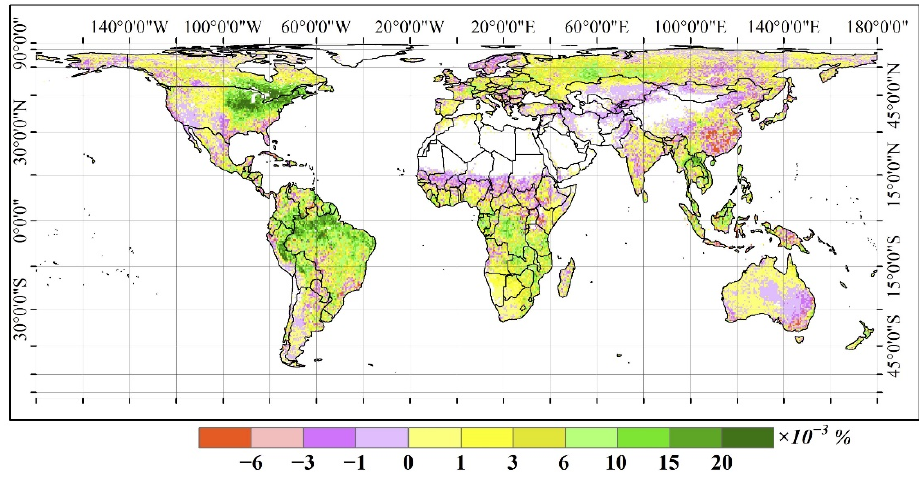
Figure 5. The spatial patterns of contribution to NEP IAV.